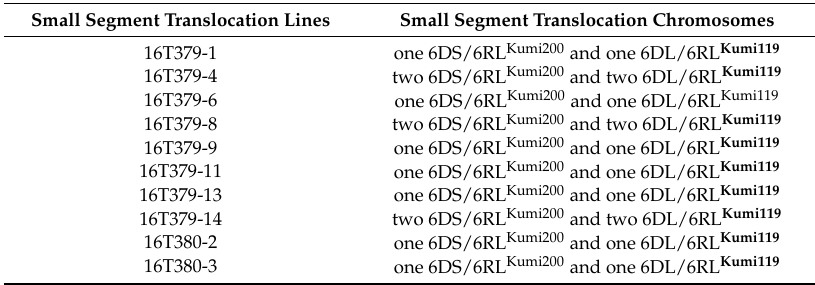
Wheat-rye 6D/6RL Ku small segment translocation lines with 6DS/6RL Kumi200 and 6DL/6RL Kumi119 translocation chromosomes.